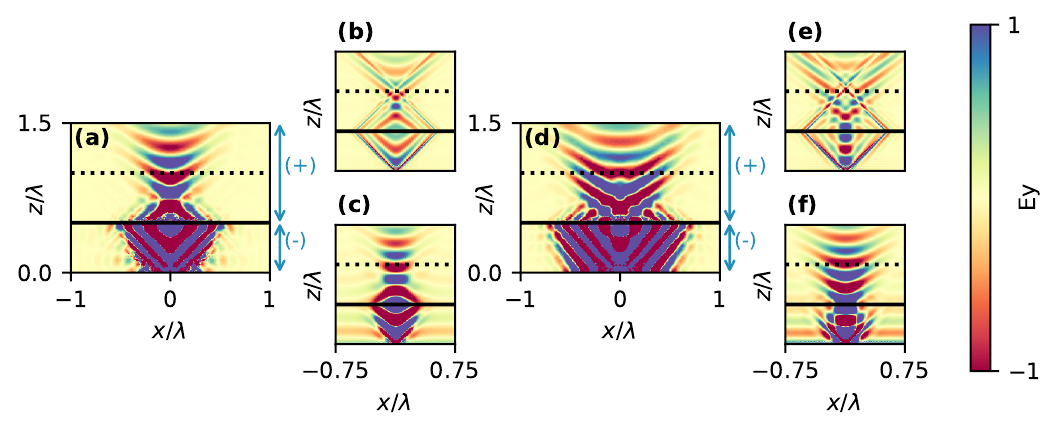
Figure 7. Comparison of surface wave implementations of a pseudocanalizing system. Full-wave simulation results of a symmetric system are shown in ( a ), with corresponding semi-analytical calculations with reduced losses ( γ = 0.01) in ( b ) and full losses ( γ = 0.1) in ( c ). Similarly ( d ) shows FEM results of an asymmetric system, with corresponding semi-analytically calculated fields for γ = 0.01 in ( e ) and γ = 0.1 in ( f ). (+) and (-) indicate regions with normal and reversed phase propagation [with geometry and material parameters specified Figure 6a for (a)–(c) and Figure 6b for (d)–(f)]. The dashed line shows the distance for which waves travelled equal distance through the two regions with opposite phase propagation properties. With ideal pseudocanalization the original source fields would be restored